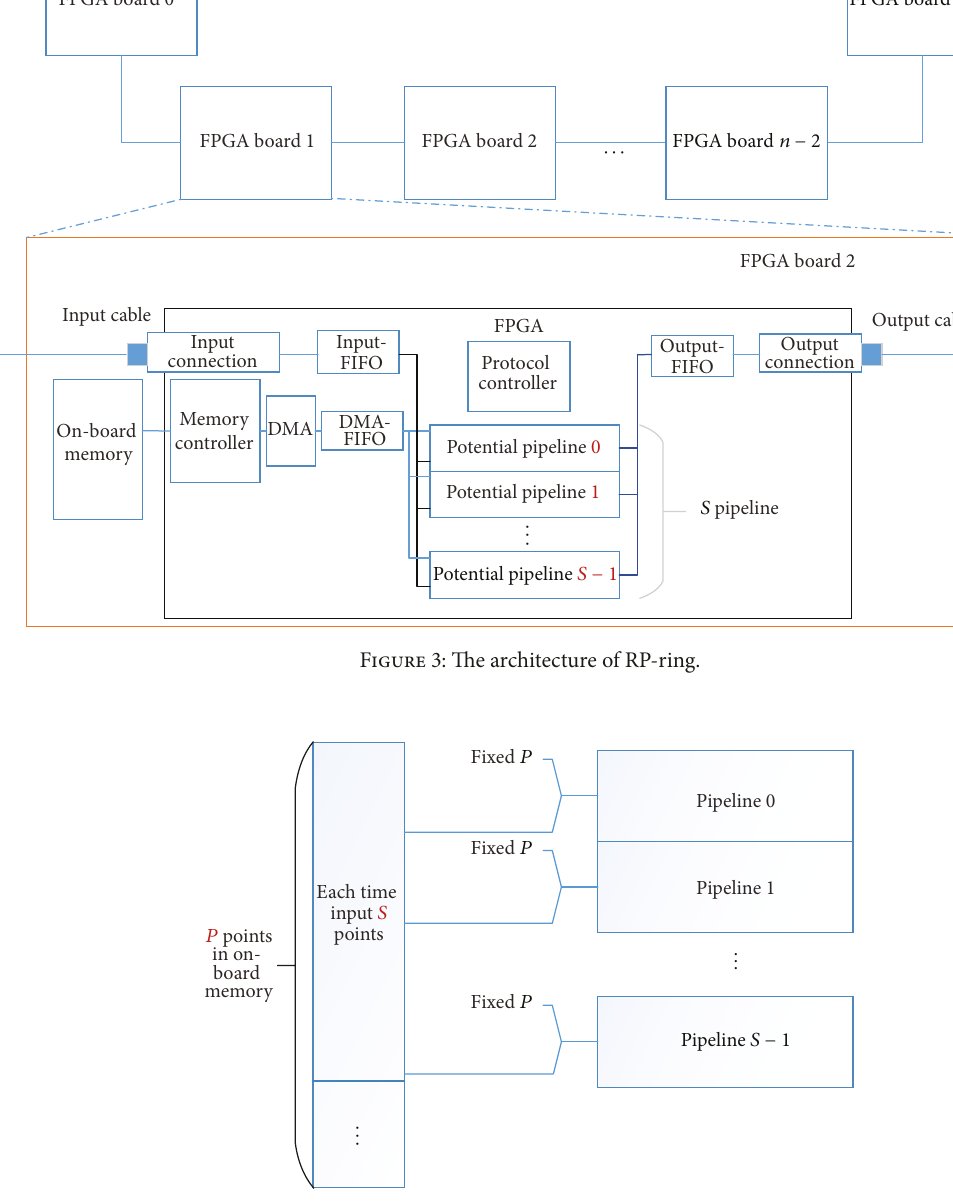
Figure 4: The input of potential